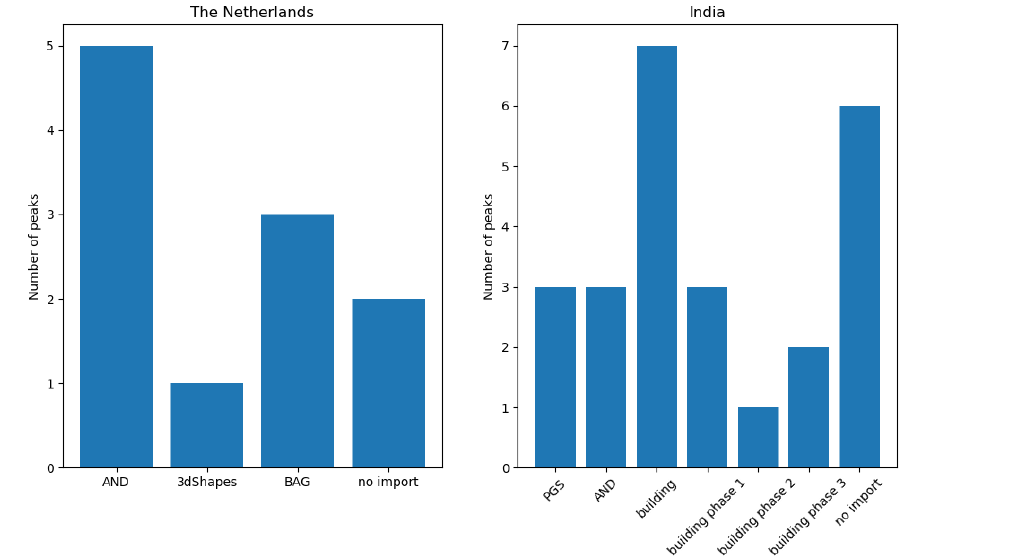
Figure 9. Numbers of detected peaks during the observation